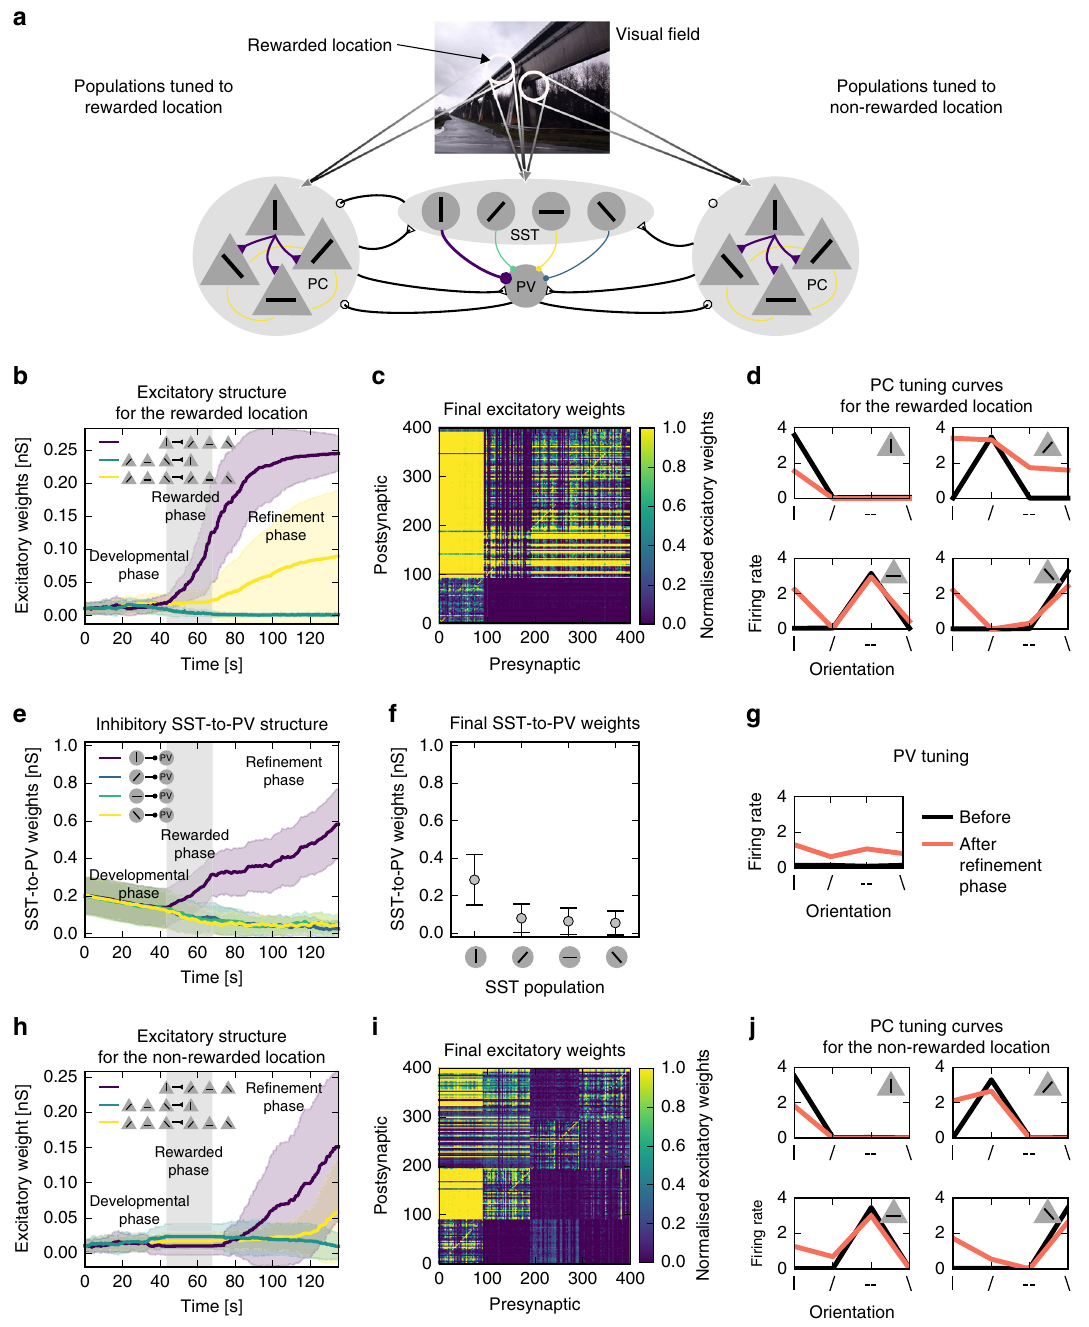
Fig. 5 Translation invariance of learned representations. a Illustration: Two excitatory networks with different visual receptive fi eld locations (white circles) share the same interneuron network. The interneurons are broadly tuned, and receive input from both visual fi eld locations. Only one visual fi eld location is rewarded during the rewarded phase (rewarded location). b Evolution of excitatory weights for the rewarded location. c Final excitatory weights for the rewarded location 1. d Tuning curves of excitatory populations with a receptive fi eld at the rewarded location at the beginning (before) and at the end of the simulation (after the re fi nement phase; measured as the number of spikes during 50 ms after stimulus onset averaged over all occurrences of that stimulus in 1 s of simulation). e Evolution of inhibitory synaptic weights. f Final inhibitory weights. g PV tuning at the beginning and after the re fi nement phase. h Evolution of excitatory weights for the non-rewarded location. i Final excitatory weights for the non-rewarded population. j Tuning curves of excitatory populations with a receptive fi eld at the non-rewarded location (as in d